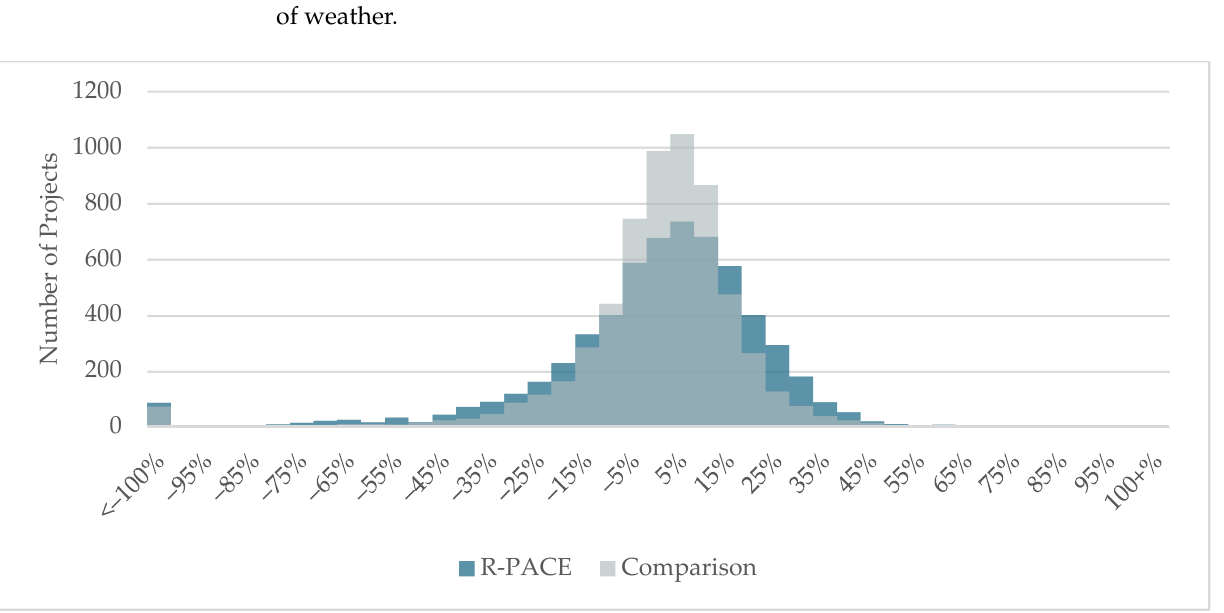
Figure 5. Distribution of household electricity savings from HVAC projects. Note that positive numbers represent savings (reductions in electricity use); negative numbers are negative savings (increases in electricity use).